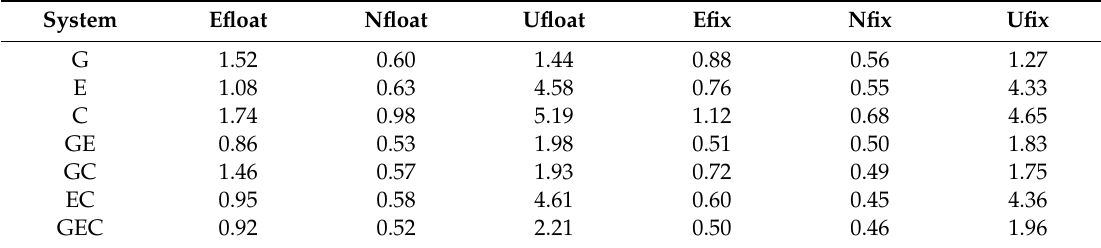
Table 1. The average RMS of float and fixed PPP solution for seven systems (unit: